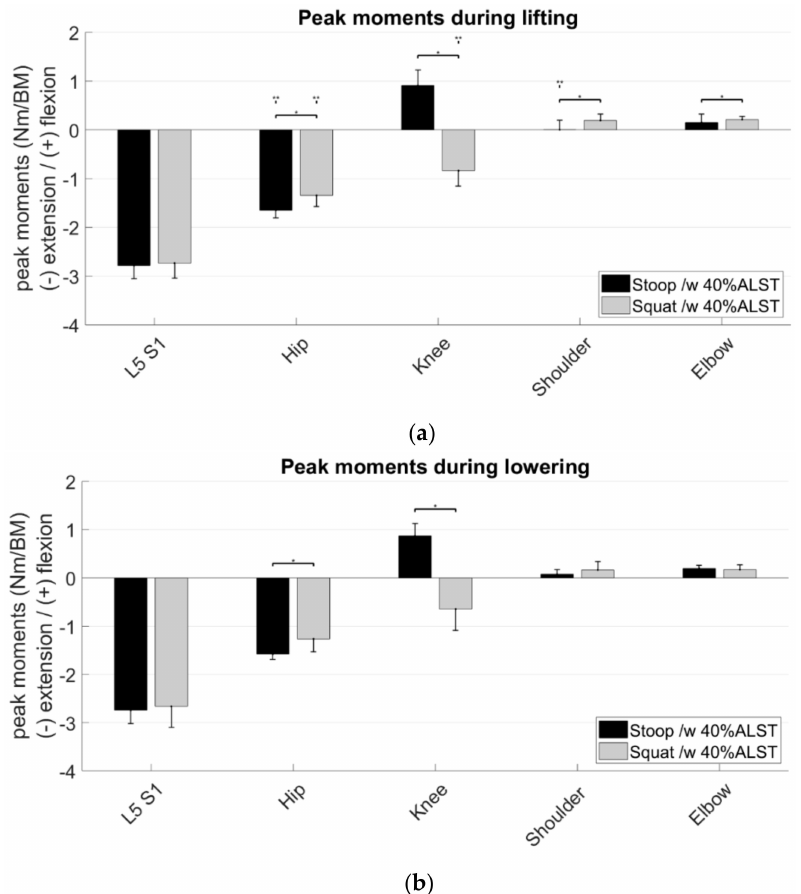
Figure 4. Peak moments normalized to body mass during the two di ff erent lifting techniques (stoop and squat) with a load equal to 40% of the arm lifting strength test. Statistical significant di ff erences ( α < 0.05) between the handling phases are indicated with three dots, and statistical meaningful di ff erences between technique and loads are indicated with one dot. Error bars indicate standard deviations. ( a ) Peak moments during the lifting phase in the five di ff erent joints (L5S1, hip, knee, shoulder and elbow); ( b ) peak moments during the lowering phase in the five di ff erent